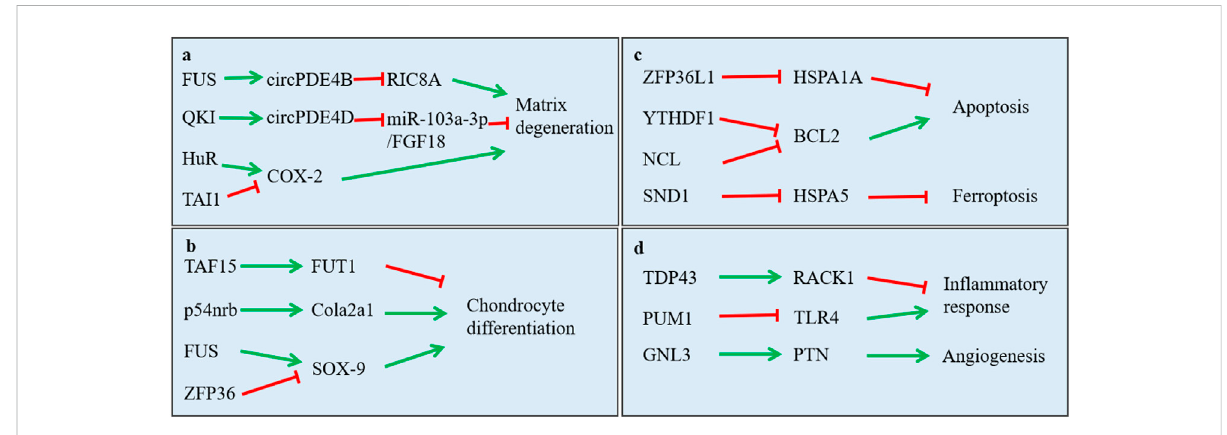
FIGURE 3 Function of RNA-binding proteins in regulating main signaling pathway in osteoarthritis. (A) regulation in extracellular matrix degradation of chondrocytes; (B) regulation in chondrocyte differentiation; (C) regulation in cell apoptosis, proliferation and ferroptosis; (D) regulation in in fl ammatory response and